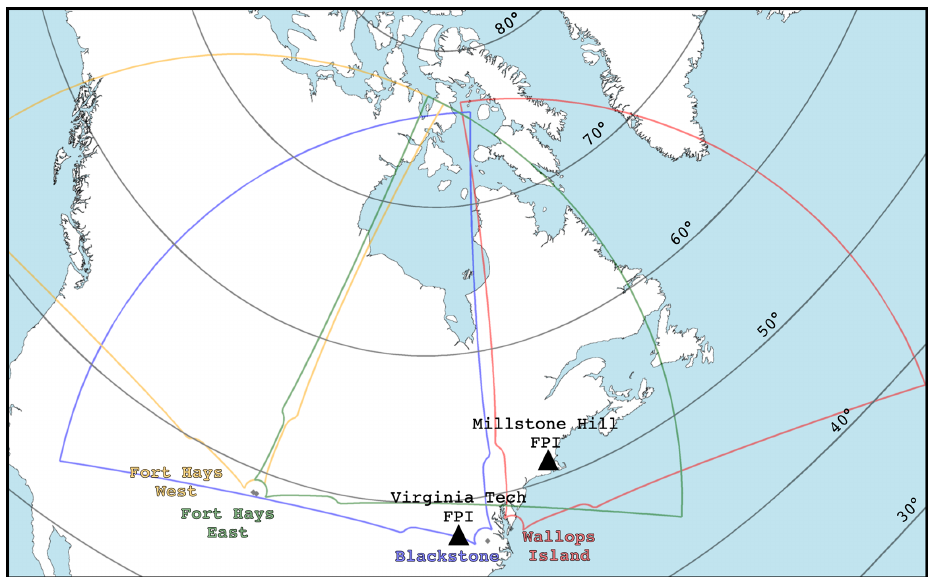
Figure 1. The fields of view of the Fort Hays West, Fort Hays East, Blackstone, and Wallops Island SuperDARN radars, up to range gate 75 (with each gate being 45km wide). Also shown are the locations of two FPIs (black triangles), with one at Millstone Hill Geospace Facility and the other at Virginia Tech (November 2013). Black lines indicate parallels of constant altitude-adjustment-corrected geomagnetic (AACGM)